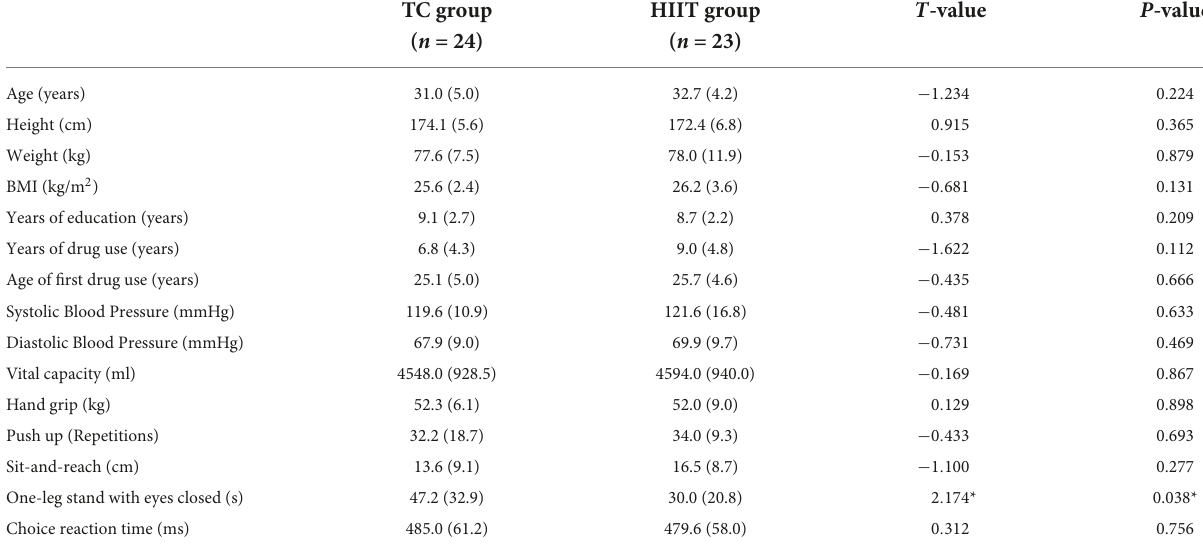
TABLE 1 Demographics of the participants at